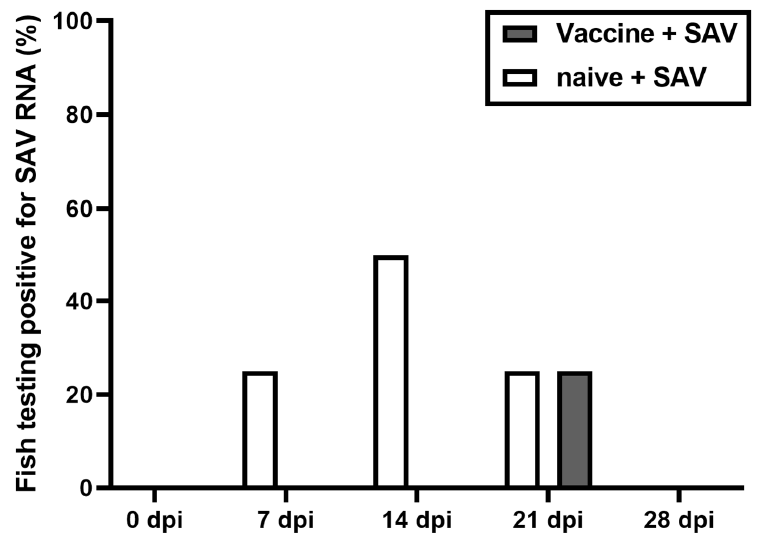
Figure 1. Percentage of fish exhibiting positive for salmonid alphavirus (SAV) by RT-qPCR in sera at 0, 7, 14, 21, and 28 days post challenge with SAV RNA in vaccinated and unvaccinated fish ( n = 4).